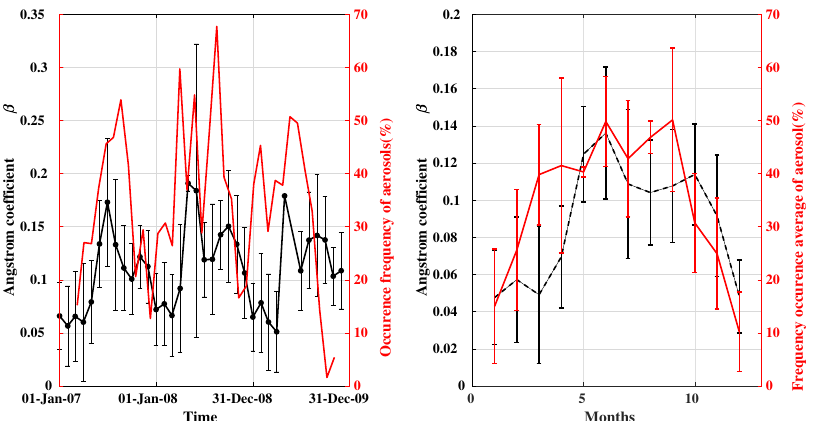
Figure 10. ( Left ): Time variations of the monthly average of β obtained from ESRA2 model (black) and frequency of occurrence of aerosols observed from space (red). ( Right ): Monthly average over 2007–2009 of β (black) and of the frequency of occurrence of aerosols (red).